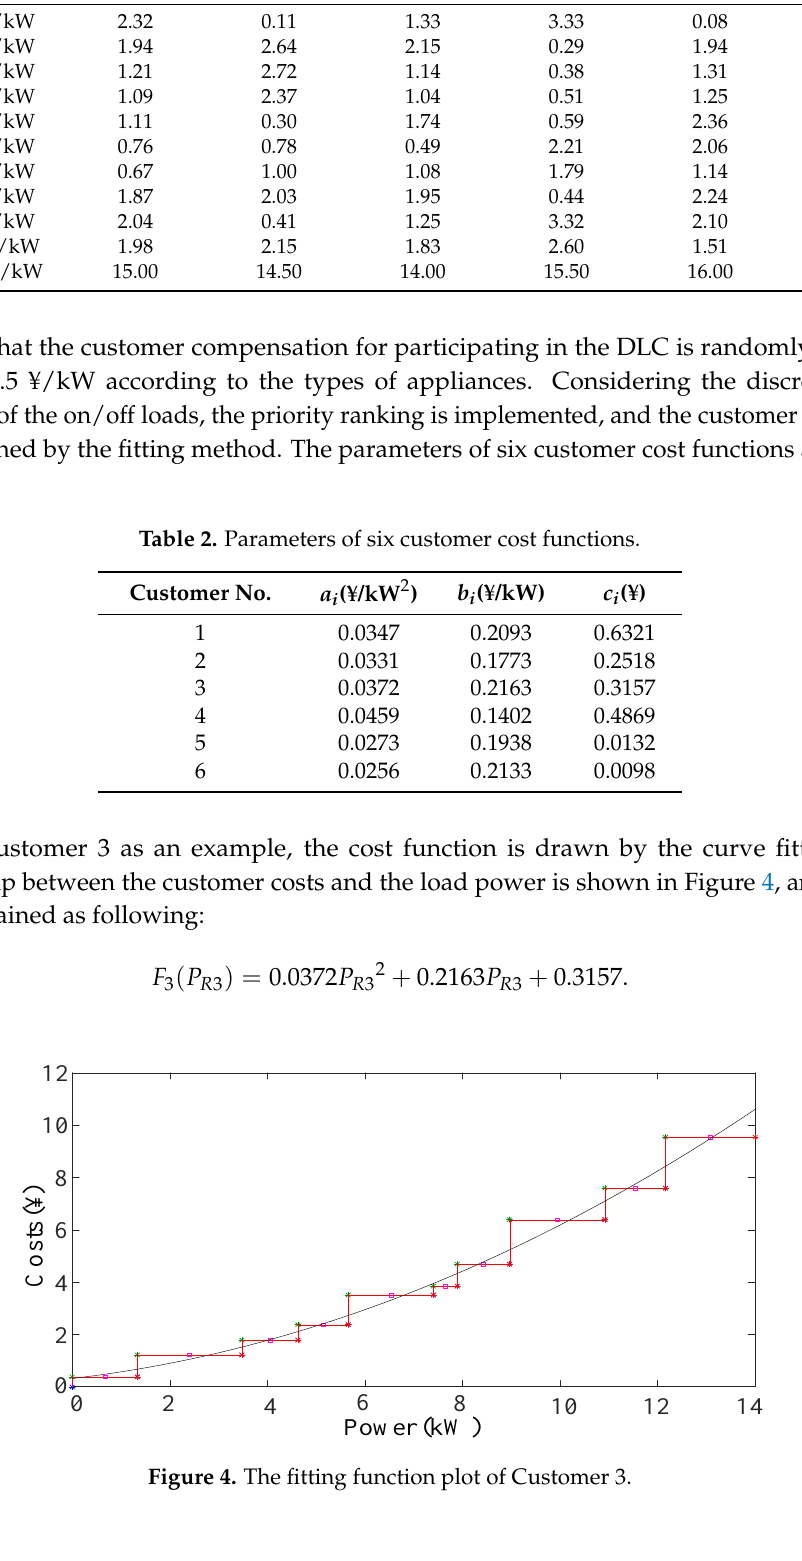
Table 1. The power capacity parameters of home appliances of six customers.